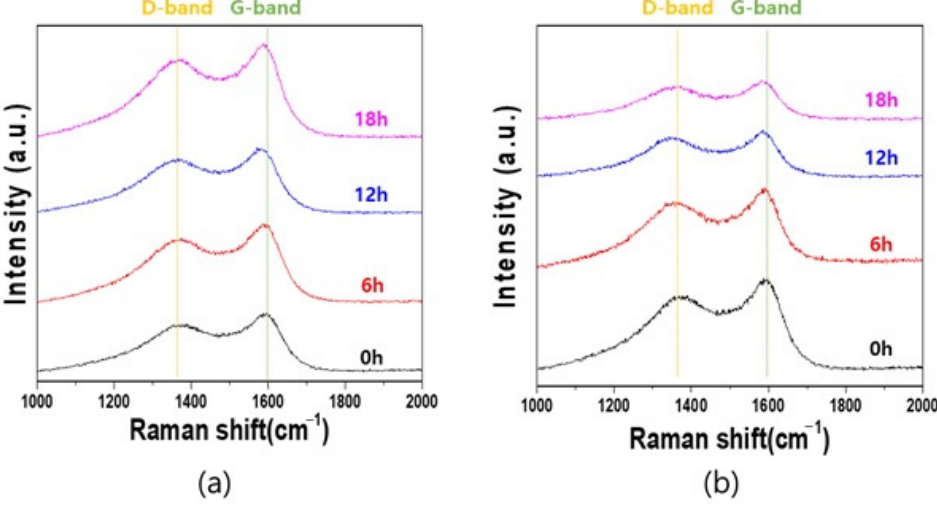
Figure 4. Raman spectra of mPCFs, ( a ) pmCF, and ( b ) mCF.